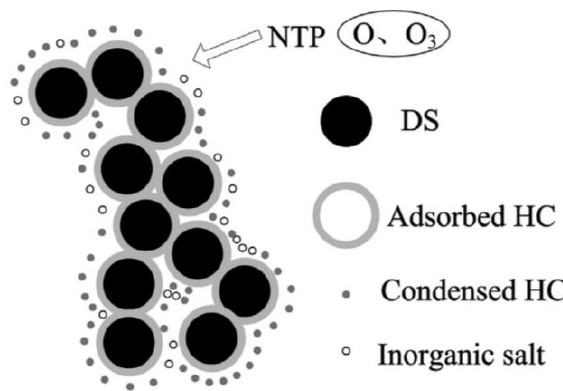
Figure 4. Decomposition of the PM in the NTP reaction model [15].